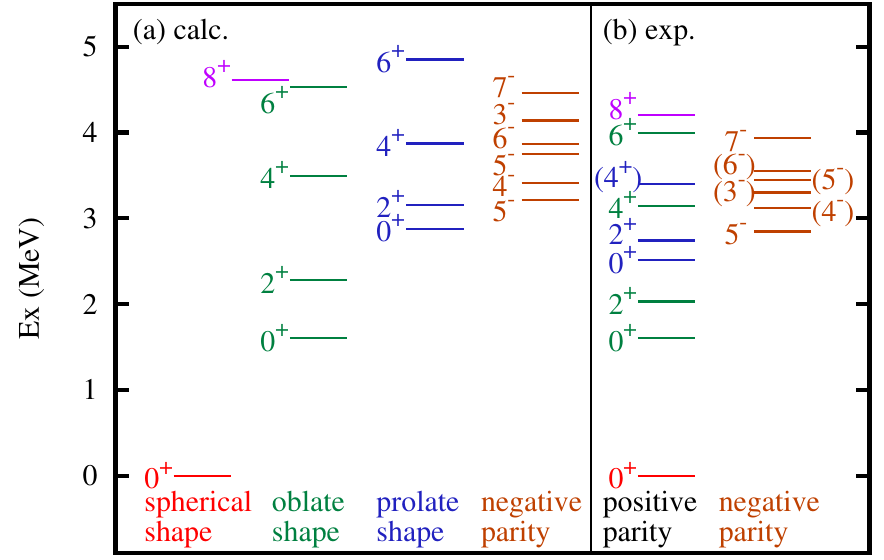
Figure 10. Level scheme of 68 Ni. Taken from Figure 2 of